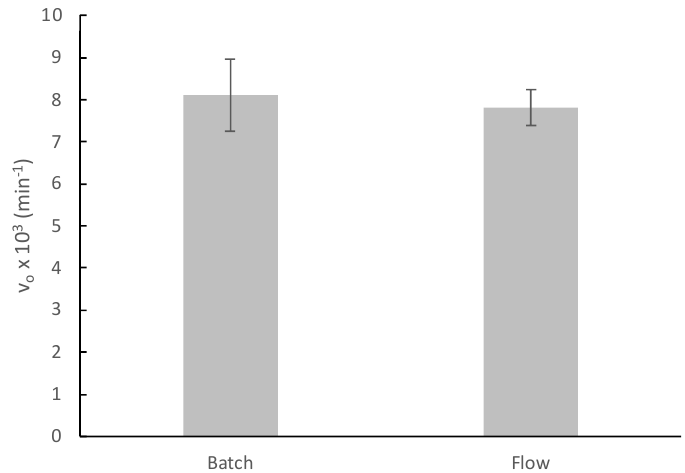
Figure 4. Peroxidase activity of the CeO 2 materials.